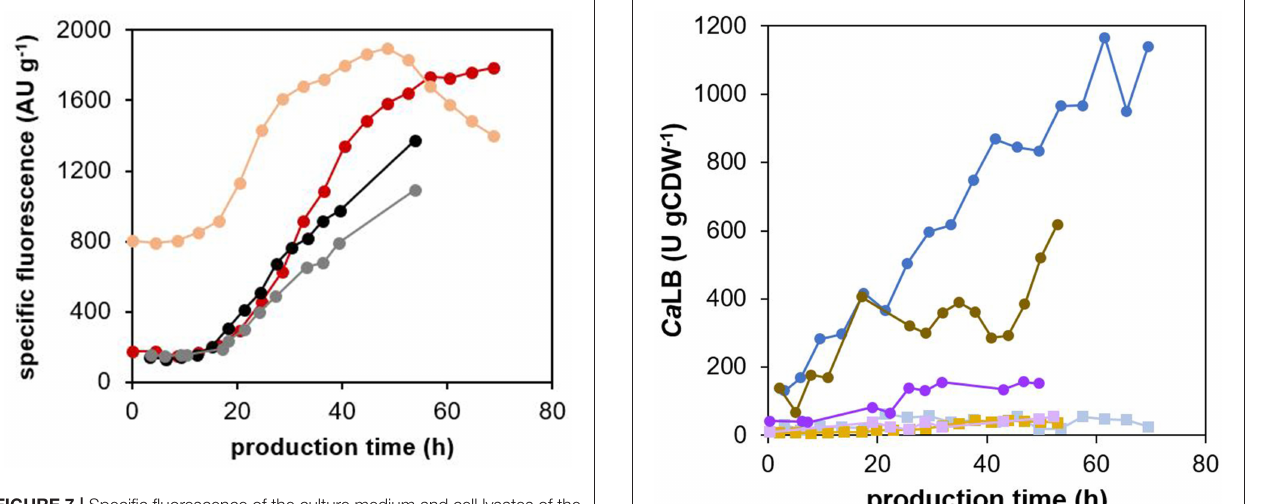
FIGURE 7 | Specific fluorescence of the culture medium and cell lysates of the P. pastoris strain producing Tl XynA, and the control strains. The P. pastoris strain producing Tl XynA was cultured at 30 ◦ C and pH 5.5, maintaining the specific growth rate of biomass with methanol during the production phase at 0.016 h − 1 . Fluorescence of the centrifuged culture medium and of the cell lysates were measured with a fluorimeter. Specific extracellular fluorescence (dark red) and specific intracellular fluorescence (light red) were calculated from the measured fluorescence (AU) and CDW (g) values. As controls, the specific extracellular fluorescence of the Ec PGA-producing strain with no sfGFP production (gray), and the non-producing strain (black) are shown. The control strains were cultured under the same cultivation conditions as the Tl XynA-producing strain.